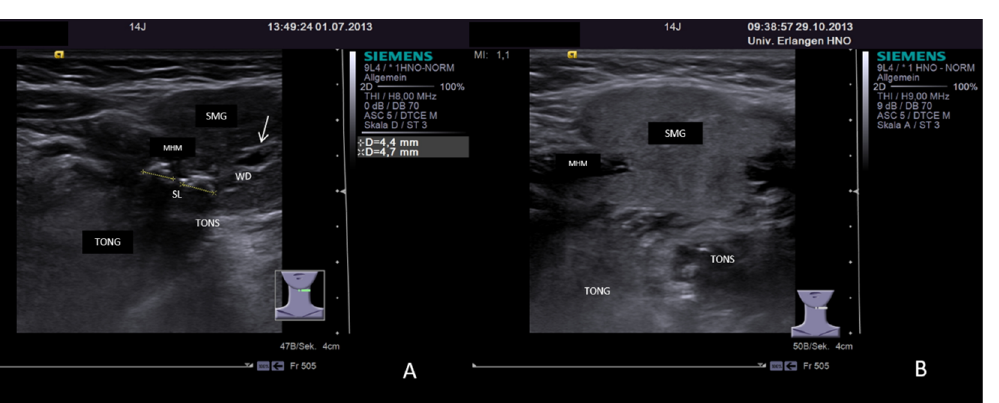
Figure 19. ( A , B ) Case of sialolithiasis of left-sided SMG in a 14-year-old patient demonstrating post-treatment recovery of the gland. Pre-treatment status shows two sialoliths within the hilum of the gland measuring 4.4 and 4.7 mm. The gland parenchyma is enlarged due to congestion with central duct dilation (white arrow, A ). Post-treatment US nearly 4 months later demonstrates recovery of the gland. The parenchyma turned out to a have a nearly normal, slightly hyperechoic tissue texture, and no duct obstruction, and congestion is no longer visible ( B ). Abbreviations: SMG, submandibular gland; MHM, mylohyoid muscle; TONG, tongue; TONS, tonsil; SL, sialolithiasis.